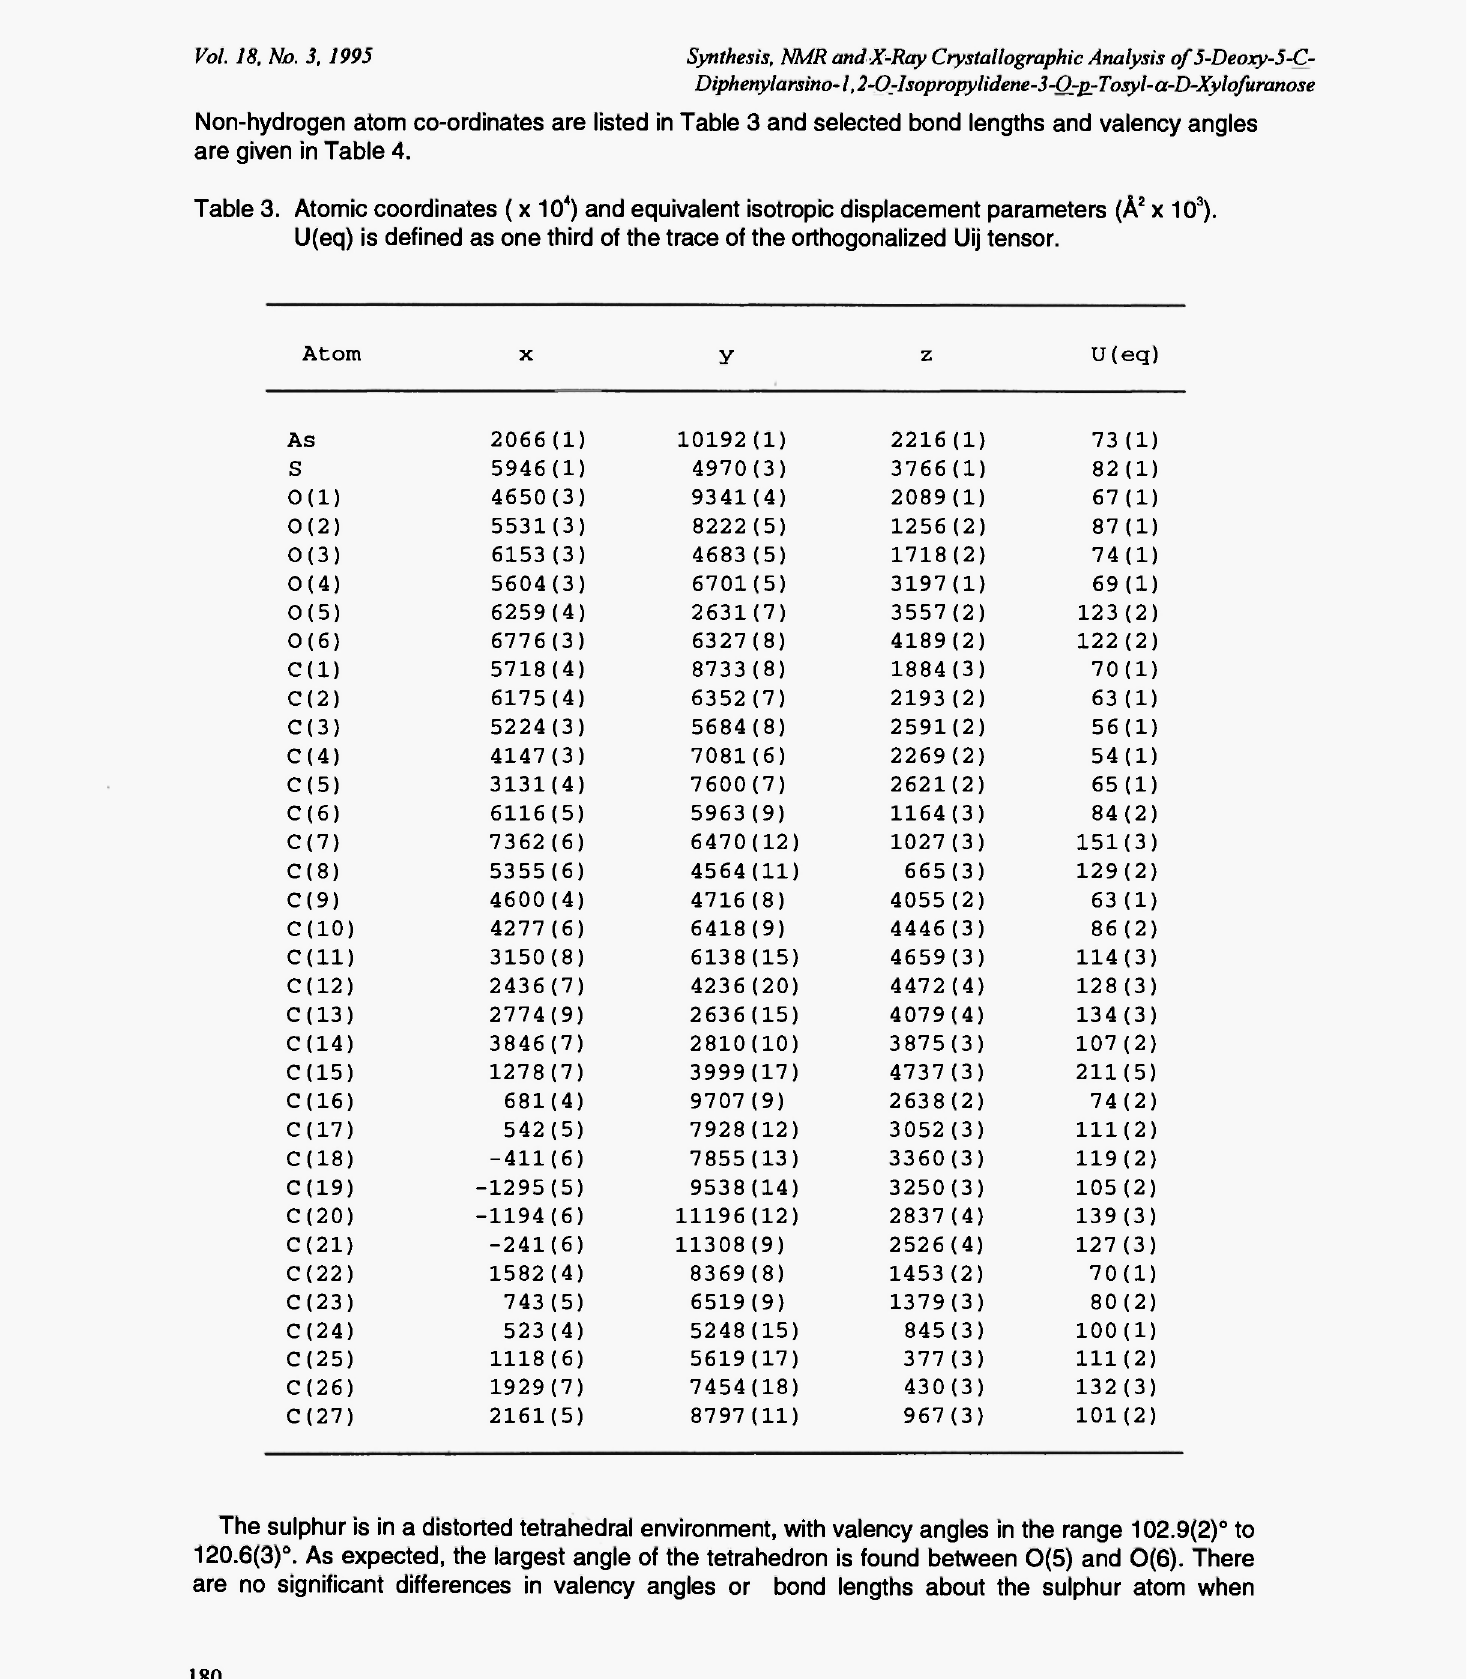
Table 3. Atomic coordinates (χ ΙΟ 4 ) and equivalent isotropic displacement parameters (Ä 2 χ 10 3 ). U(eq) is defined as one third of the trace of the orthogonalized Uij